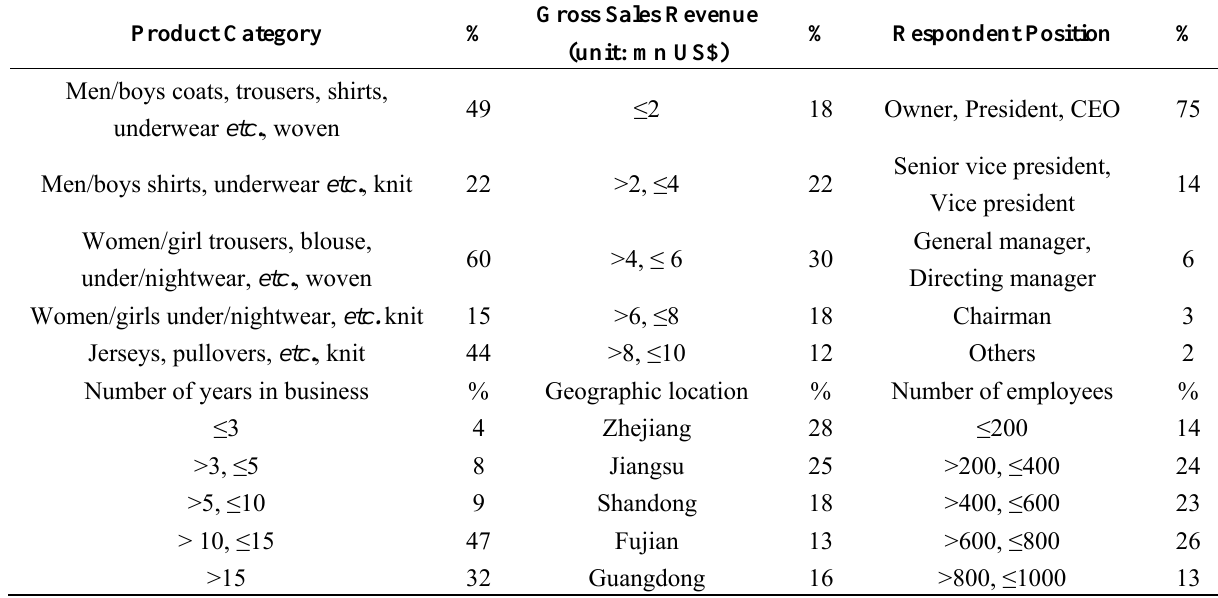
Table 2. Profile of the participating Chinese apparel SMEs in the